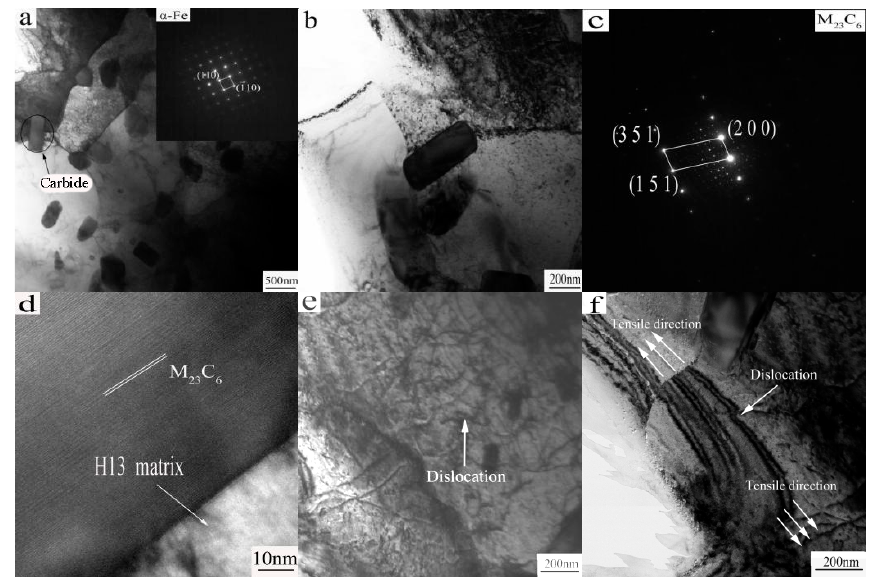
Figure 6. HREM morphology of the specimen after stretching: ( a – f ) 850 °C and 1 × 10 − 4 s − 1 .